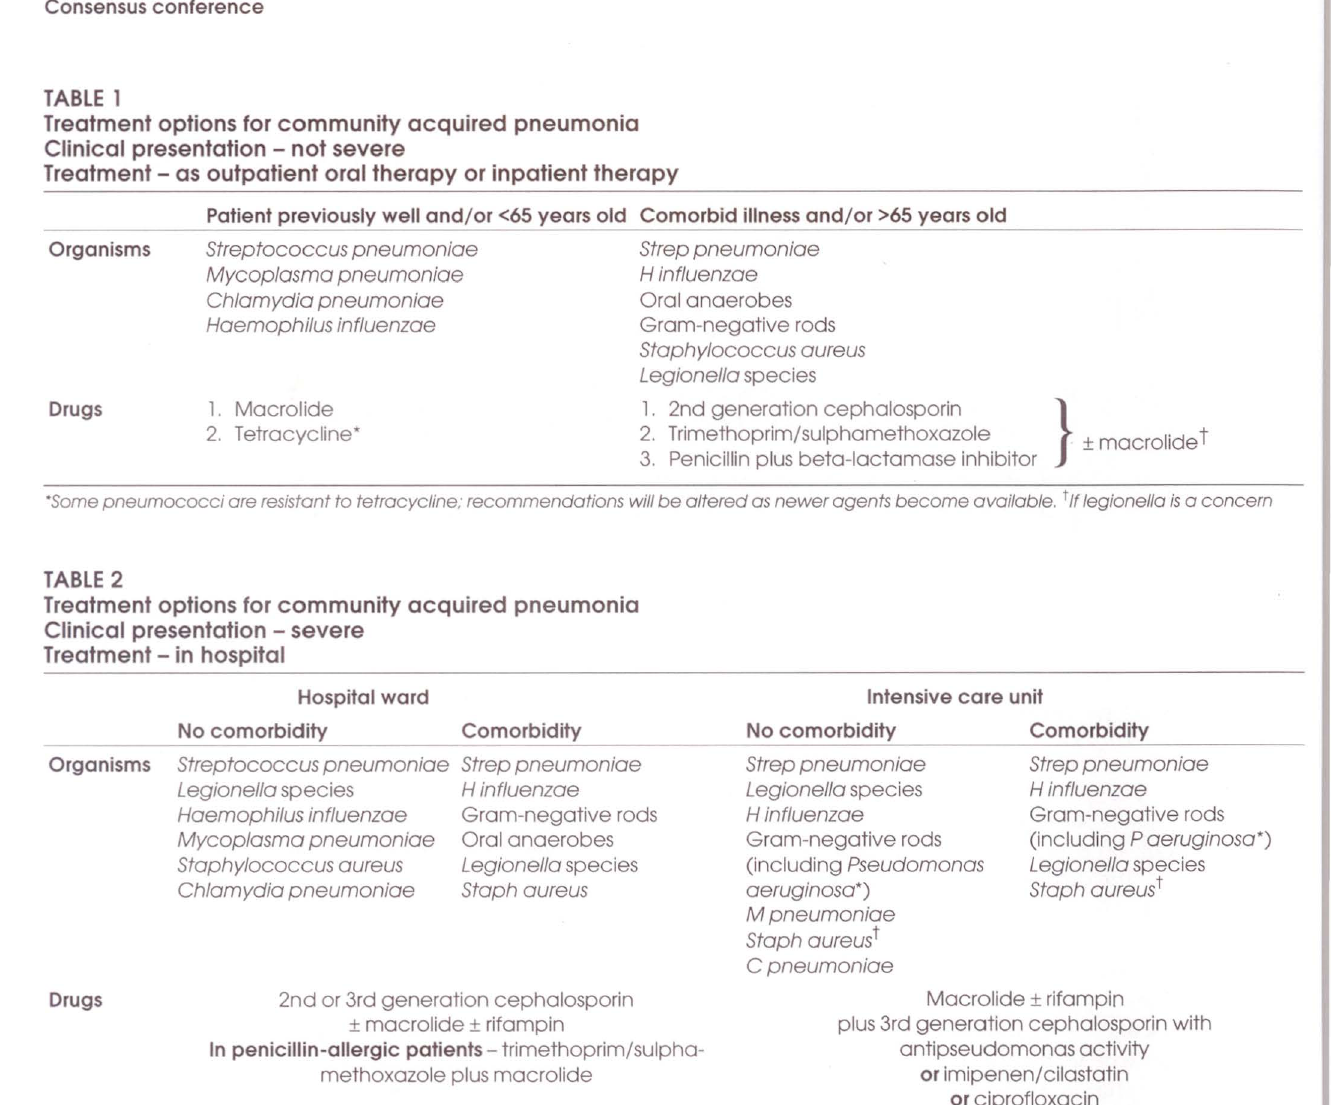
TABLE 1 Treatment options for community acquired pneumonia Clinical presentation - not severe Treatment- as outpatient oral therapy or inpatient therapy Patient previously well and/or <65 years old Comorbid illness and/or >65 years old